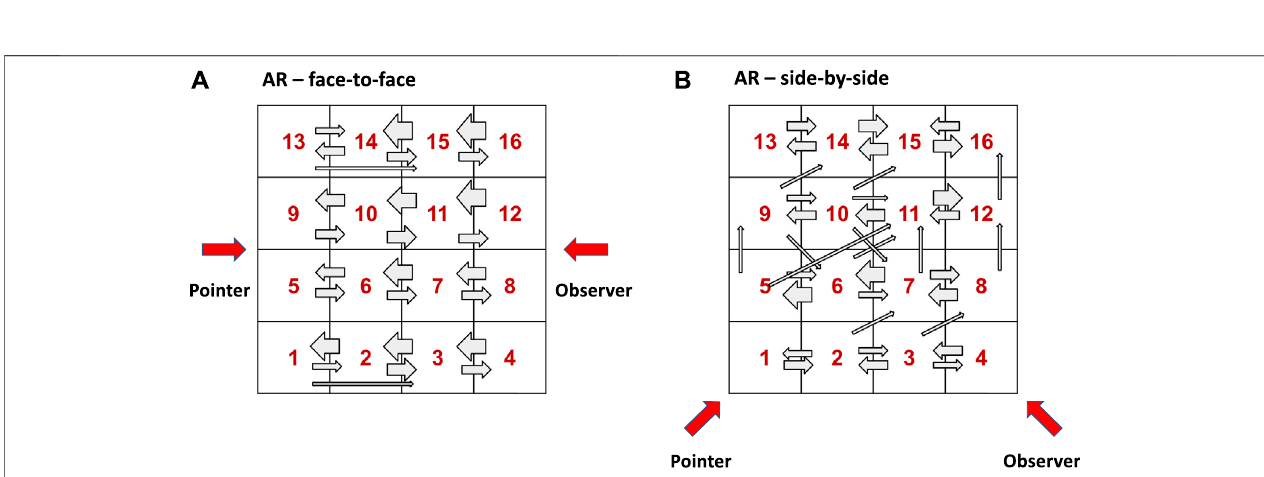
FIGURE 8 | The thickness of each arrow represents the number of errors. The head and tail of the arrow indicate the observer ’ s selection and what the correct answer was. For example, a thick left arrow pointing from 2 to 1 visualizes the number of observers who answered Cube 1 when pointers were pointing at Cube 2. All errors are horizontal in the AR/face-to-face condition (A) , whereas there are some diagonal and vertical errors in the AR/side-by-side condition (B) .